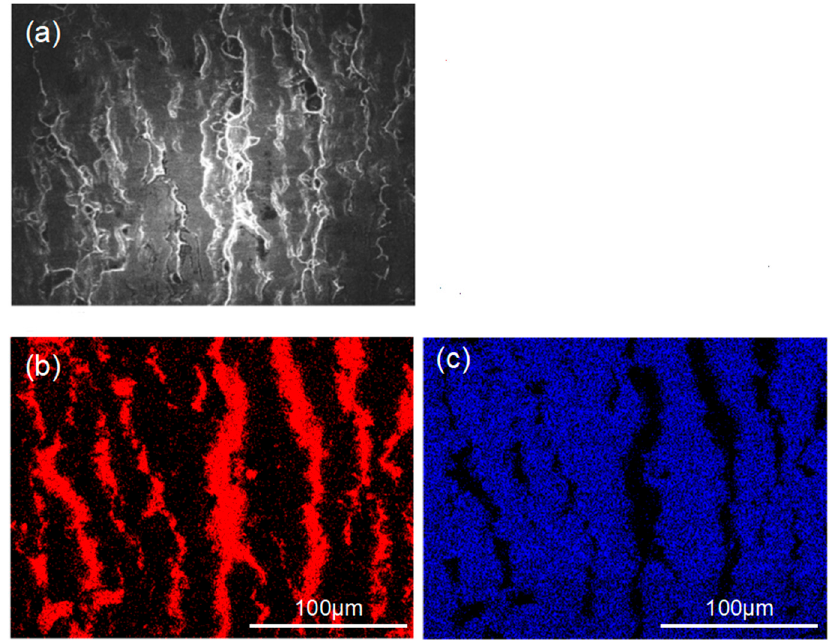
Figure 9. SEM images of the peeled surface on the titanium side of specimen C3. ( a ) Secondary electron SEM micrographs; ( b ) distribution of Al element (red areas) in ( a ) obtained by EDS; ( c ) distribution of Ti element (blue areas) in ( a ) obtained by EDS.